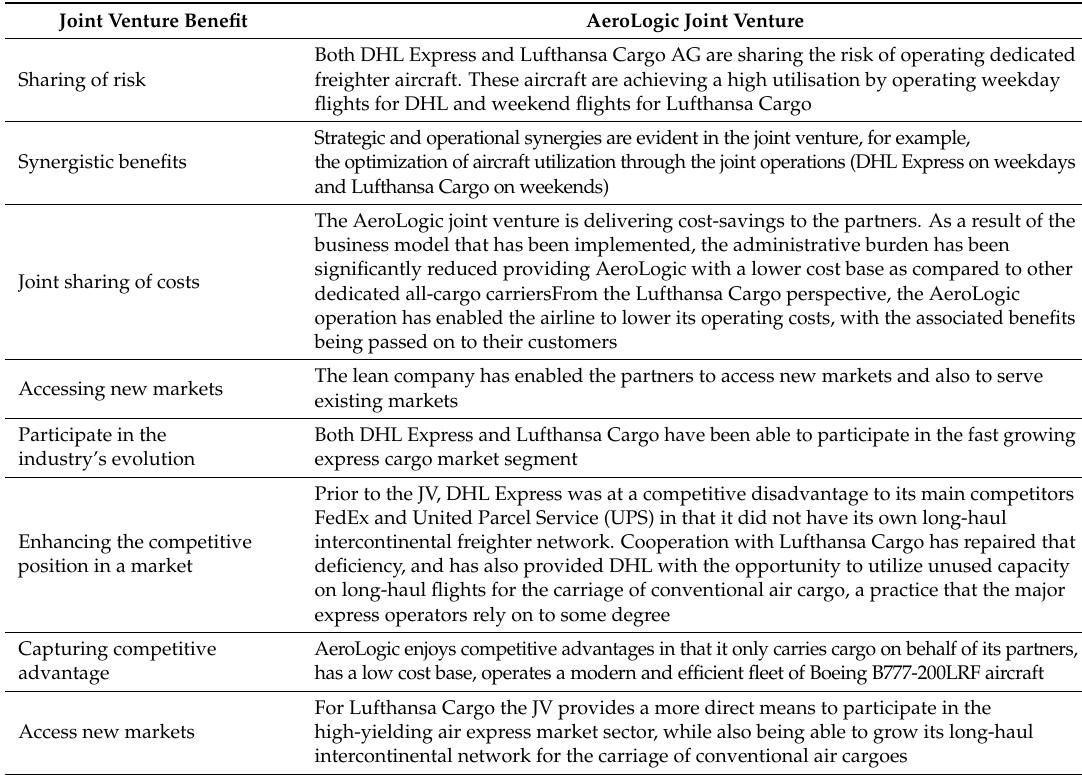
Table 4. The AeroLogic joint venture